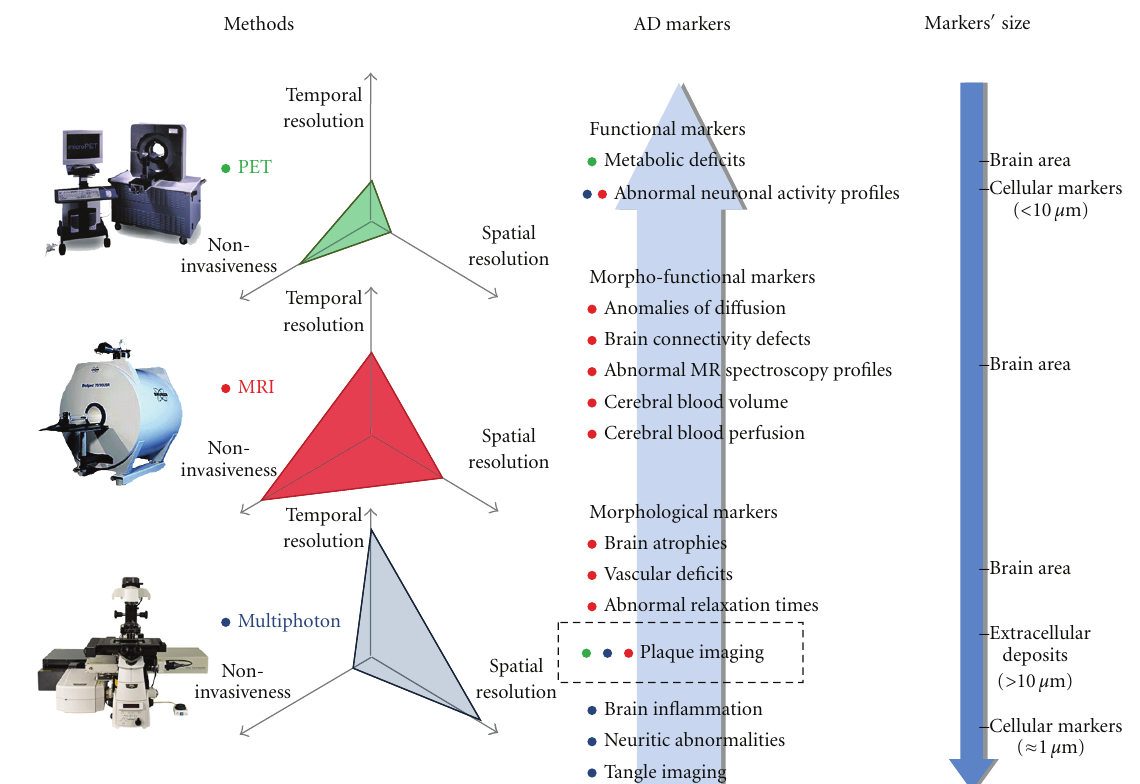
Figure 1: Summary of imaging techniques. This figure schematizes the principal methodologies and tools that can be used to image in vivo the brain lesions and functional alterations developed by mouse models of AD. Radioligands analyzed by PET (green dots) can be used to map brain metabolic deficits in APP(xPS1) transgenic mice. Their relevance for plaque detection in mouse models is more controversial. Applications derived from small animal MR-based imaging techniques (red dots) are more versatile. MRI allows the detection of pathological markers at the regional level (e.g., evaluation of brain atrophy) and also at a microscopic resolution (e.g., visualization of amyloid plaques). In vivo MRI is also a tool to assess functional markers of the pathology such as anomalies in brain perfusion. The recent development of manganese-enhanced MRI has opened new opportunities to map in vivo brain connectivity and neuronal activity with an exquisite spatial resolution. The detection of discrete markers at the (sub)cellular level relies today on the use of high resolution, but also more invasive, imaging techniques that require direct access to brain tissues through a craniotomy in anaesthetized animals: with multiphoton microscopy (blue dots) it is for instance possible to detect intraneuronal neurofibrillary tangles as well as dystrophic neurites in APP(xPS1) transgenic